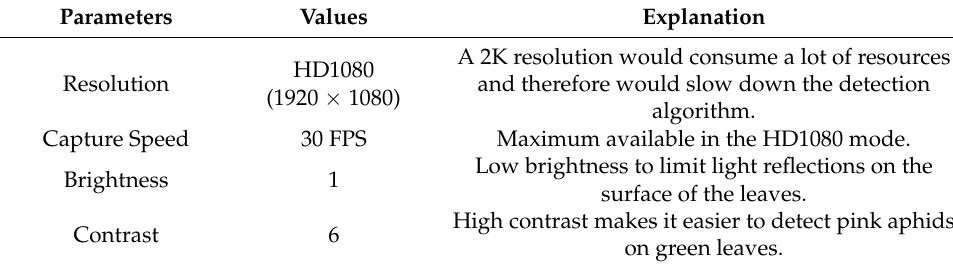
Table 1. Configuration of various parameters of the ZED